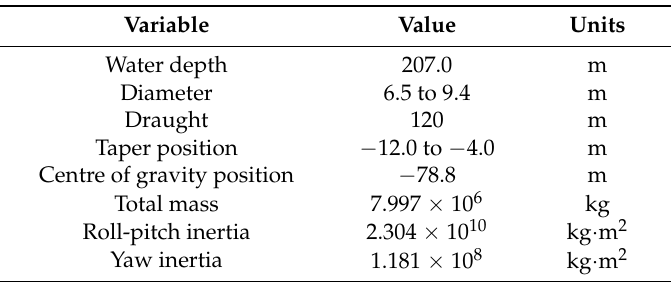
Table 1. Main characteristics of the structure.